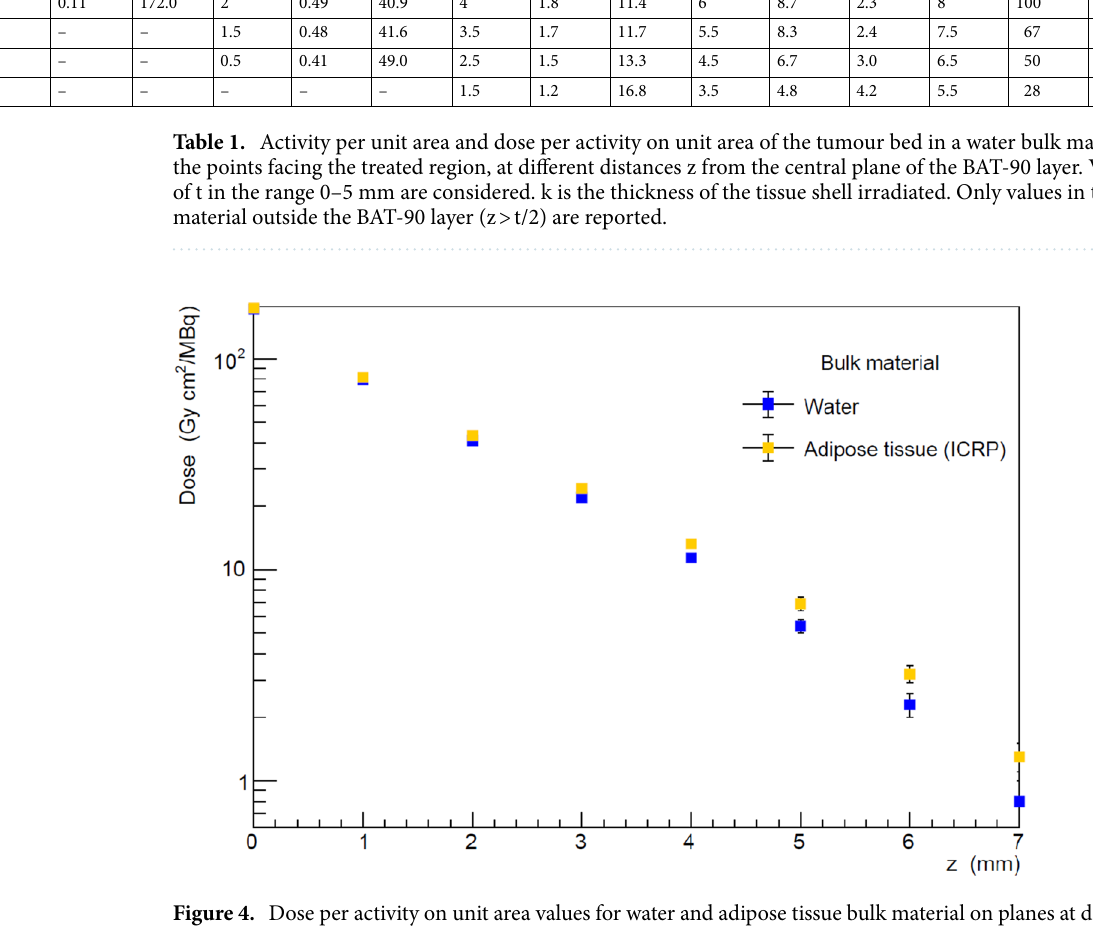
Figure 4. Dose per activity on unit area values for water and adipose tissue bulk material on planes at different distances z from the tumour bed. The values are obtained for a BAT-90 thickness t = 0 mm. The dose in adipose tissue is larger than the one in water and the effect increases with z.